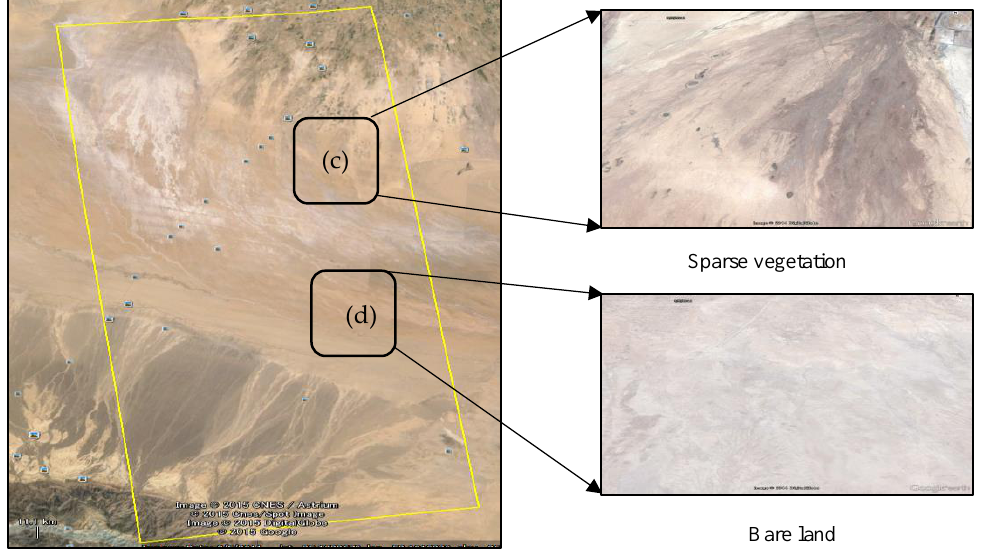
Figure 9. The footprint of ALOS on Google Earth. Rectangles (c,d) indicate the two different land cover types and correspond to the same position of rectangles placed on the soil moisture map in Figure 8.